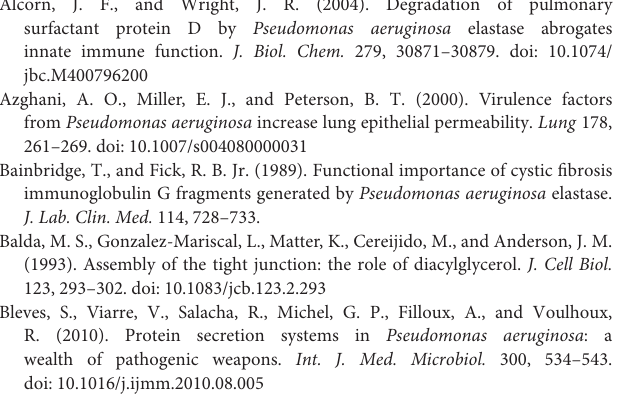
Supplementary Table 1 | Elastase activity and protein concentrations for PAO1 and clinical isolates. Supplementary Table 2 | Demographics, disease severity scores, elastase activity and multi-locus sequence typing (MLST) analysis of P. aeruginosa clinical